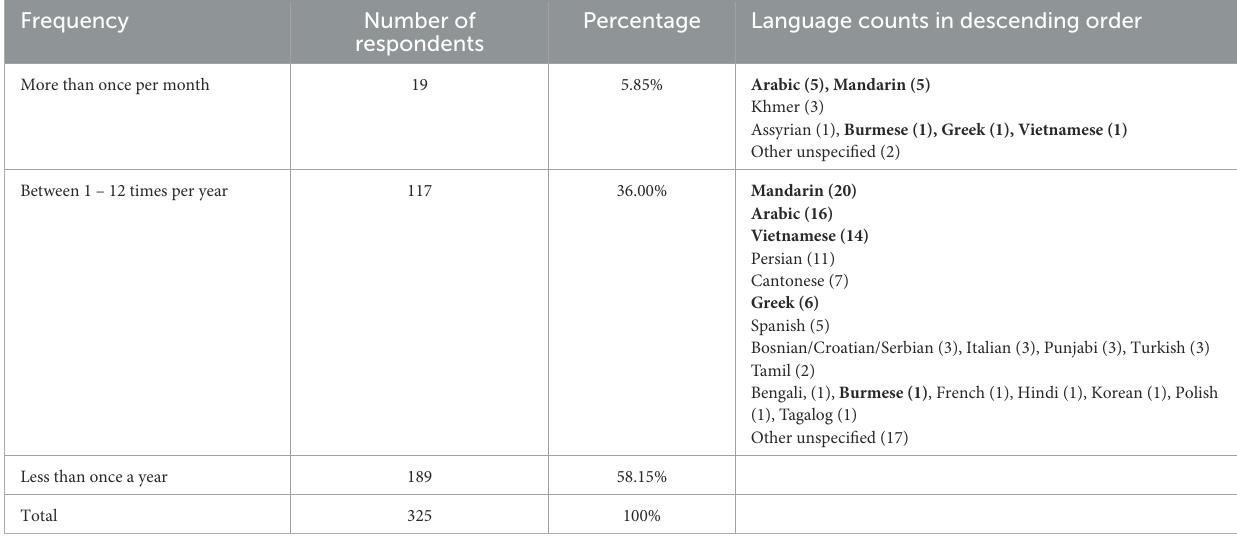
TABLE 4 FTT work frequency and corresponding